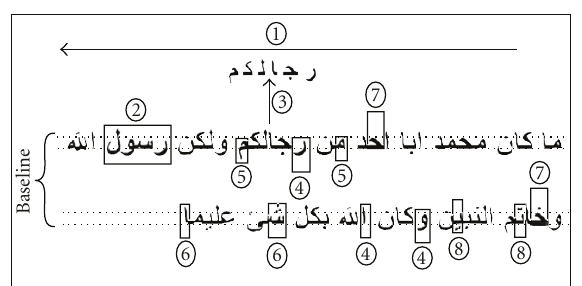
Figure 1: An Arabic sentence demonstrating the main character- istics of Arabic text [12]. (1) Written from right to left. (2) One Arabic word includes three cursive subwords. (3) A word consisting of six characters. (4) Some characters are not connectable from the left side with the succeeding character. (5) The same character with di ff erent shapes depends on its position in the word. (6) Di ff erent characters with di ff erent sizes. (7) Di ff erent characters with a di ff erent number of dots. (8) Di ff erent characters have the same number of dots but di ff erent positions of